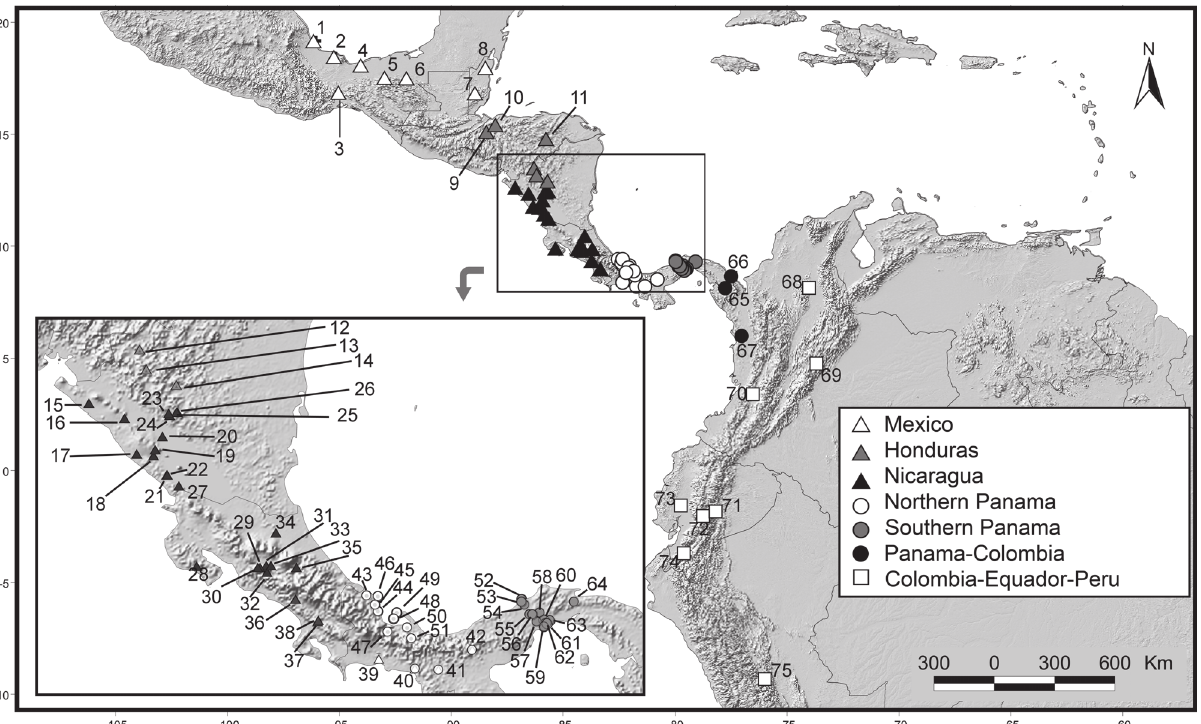
Figure 2. Distribution of the localities of Caluromys derbianus with specimens included in this study. Localities were grouped in popula- tions for subsequent analyses, and are labelled accordingly. Numbers indicate localities as listed in Appendix